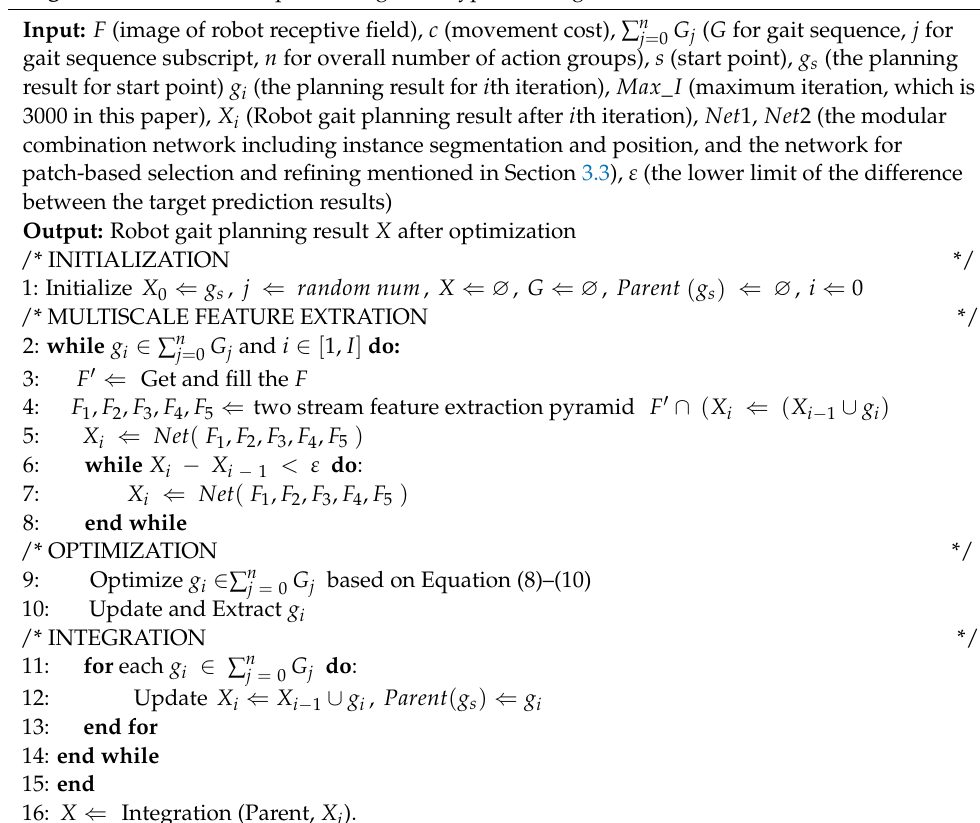
Algorithm 1 . Multi-scale positioning for waypoint